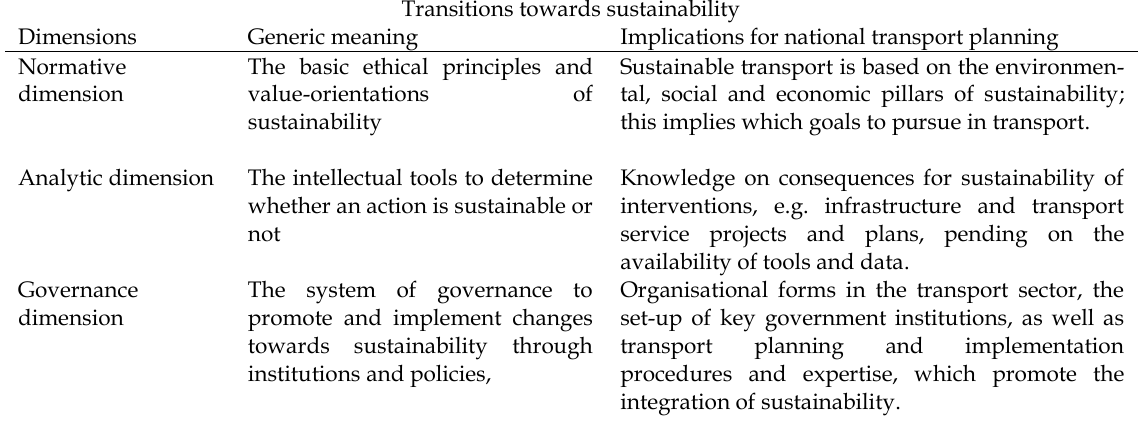
Table 1. Transition towards sustainability - three dimensions (Sørensen et al., 2013). Transitions towards sustainability Implications for national transport